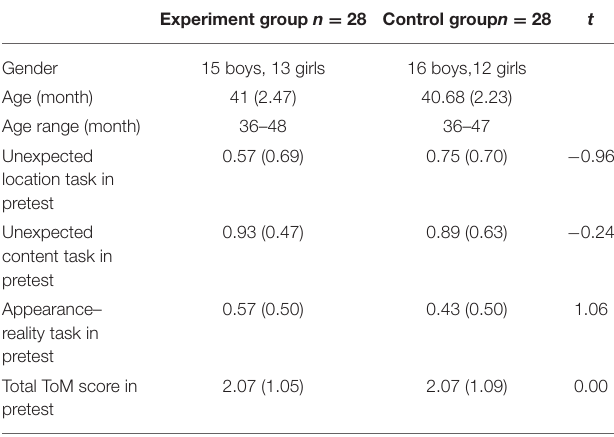
TABLE 1 | Descriptive statistics for the experimental and control groups in